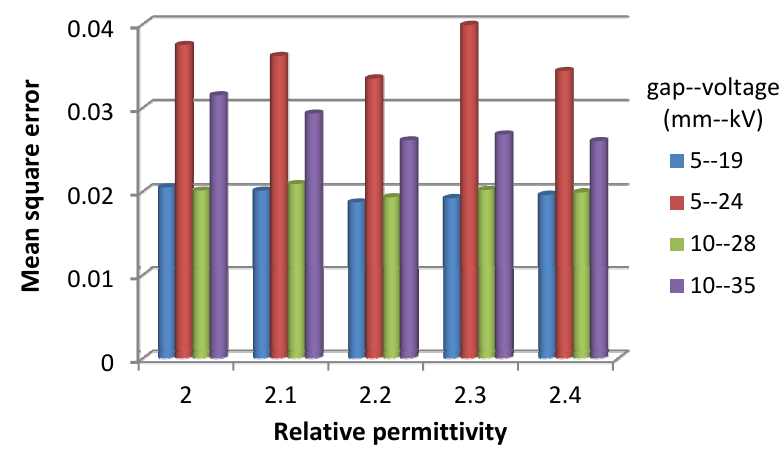
Figure 3. Mean square error